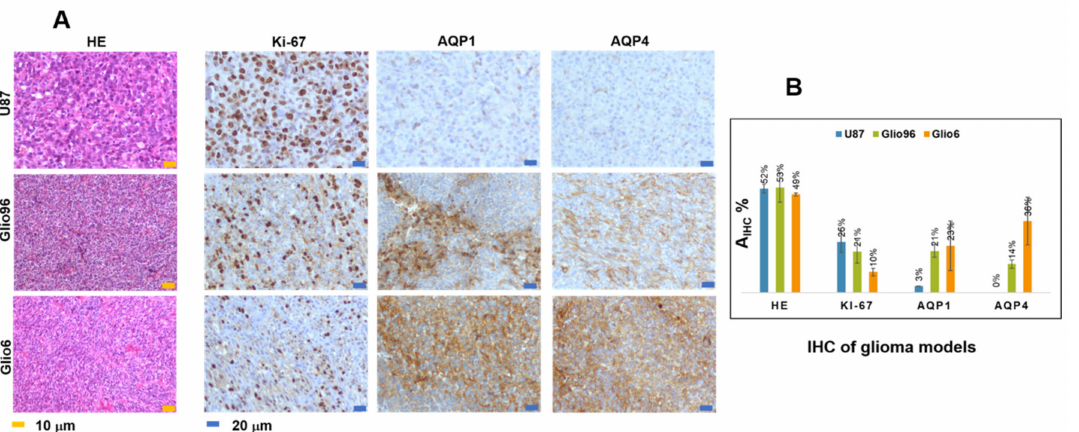
Figure 3. ( A ): Typical histological images: HE ( × 100) and IHC of Ki67, AQP1, and AQP4 of the three glioma models U87, Glio6, and Glio96 ( × 200). In HE histology, cell nuclei are stained in blue and in Ki-67, AQP1, and AQP4 IHC, the positive expressions are stained in brown. ( B ): IHC expression quantified by the parameter A IHC+ %. Overall, IHC data confirm U87 as a proliferation glioma model (high Ki67 expression) and Glio6 and Glio96 as invasion model (low Ki-67 expression related to high AQP1 and AQP4